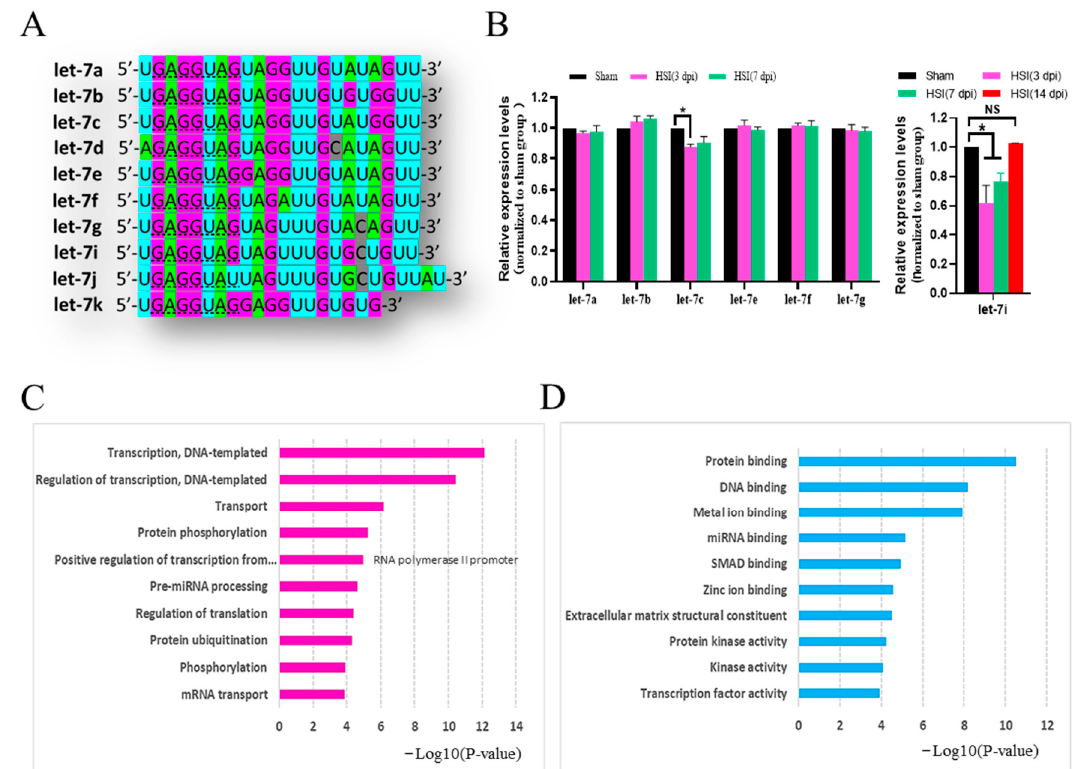
Figure 1. Let-7i was significantly downregulated in the hippocampus at days 3 and 7 post-injury. ( A ) Let-7 family members share the same “seed sequence” (dashed underline) and are slightly distinct from each other by a few ribose nucleotides. ( B ) Relative expression levels of let-7 family members in the hippocampus were detected by qRT-PCR. U6 was used as the internal control. All data are presented as the mean ± SEM. n = 4 mice per group. NS, non-significant; * p < 0.05. ( C , D ) Top ten biological processes ( C ) and molecular functions ( D ) of let-7i predicted targets annotated by the Gene-ontology (GO) enrichment analysis.